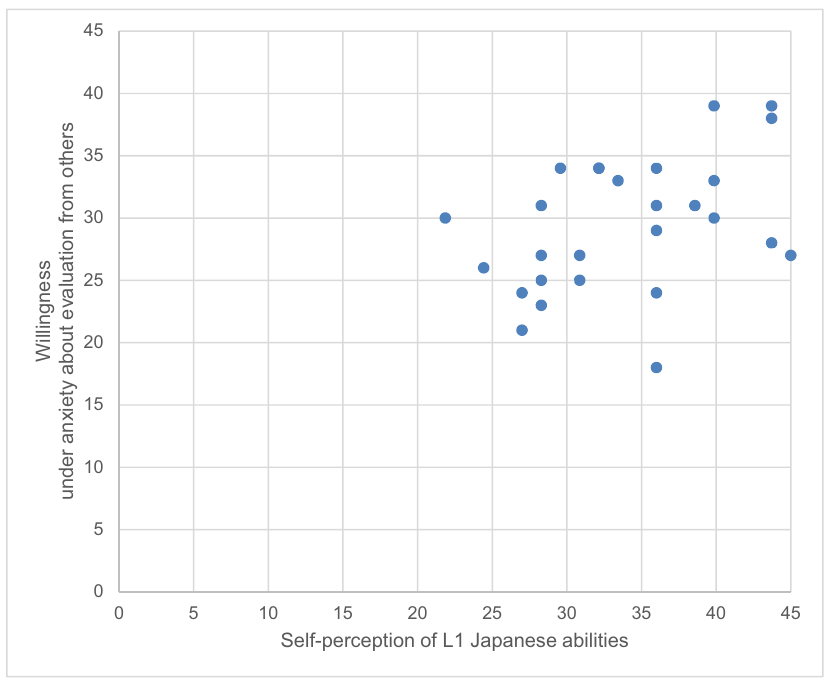
Figure 7: Correlation between willingness under anxiety about evaluation from others and self - perception of L1 abilities ( Likert points )